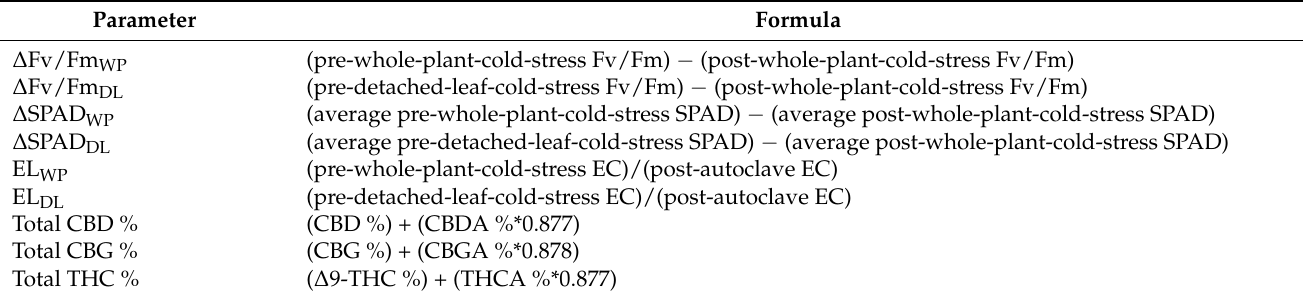
Formulas used in analysis of chlorophyll fluorescence, SPAD, electrolyte leakage, and